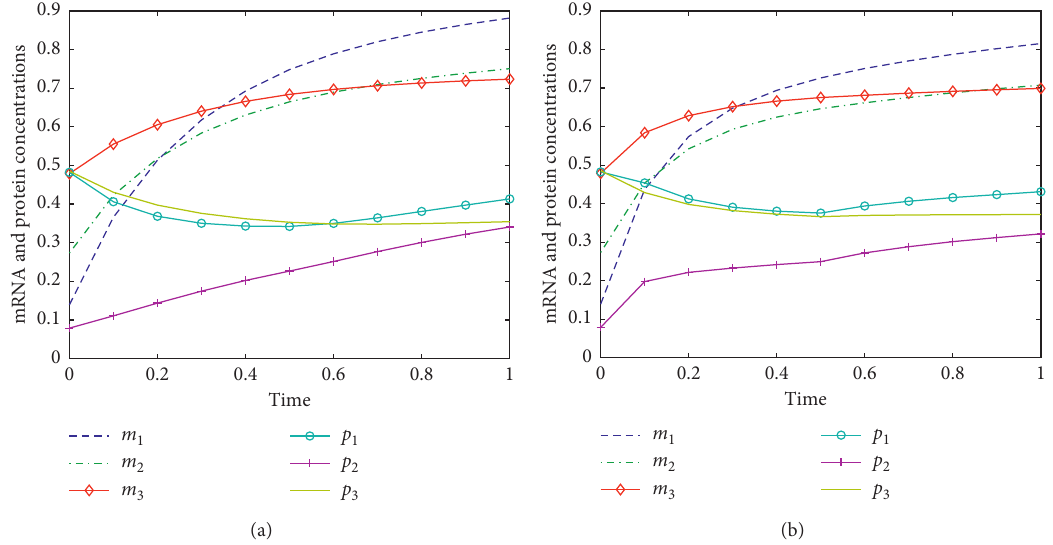
Figure 1: Transient states of DFGRN (57) with (a) q � 0 . 95 and (b) q � 0 .